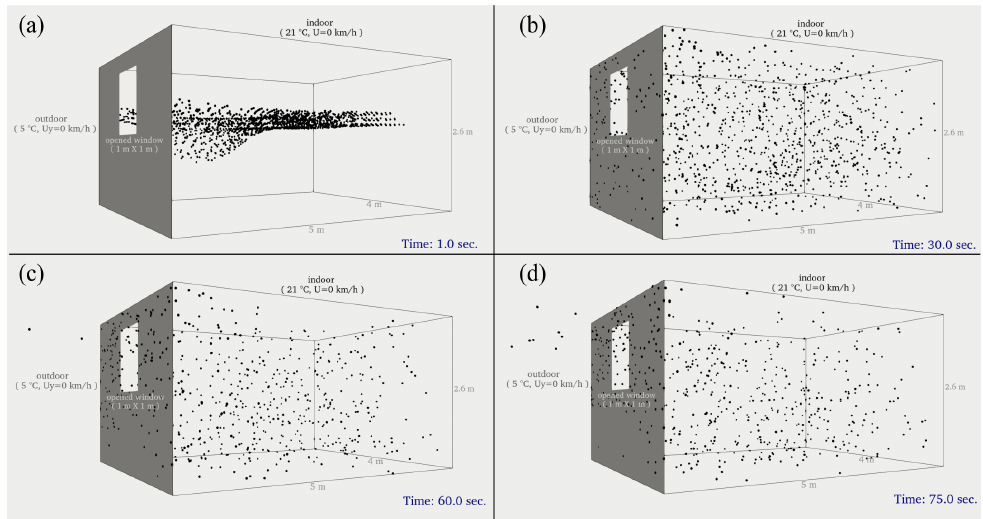
Figure 6. Local dispersion of aerosol particles indoor-outdoor. Case: Natural ventilation due to a negligible wind speed outdoors U = 0 and a lower outdoor temperature, walls-particles- interaction: unstick . ( a ) t = 1 s shows the initially stratified layer of 3108 aerosol particles (0.15 µ m in diameter) placed between z = 1.5 m and z = 1.7 m; ( b ) t = 30 s; ( c ) t = 60 s; ( d ) t = 75 s. See the Supplementary Materials Video S1.